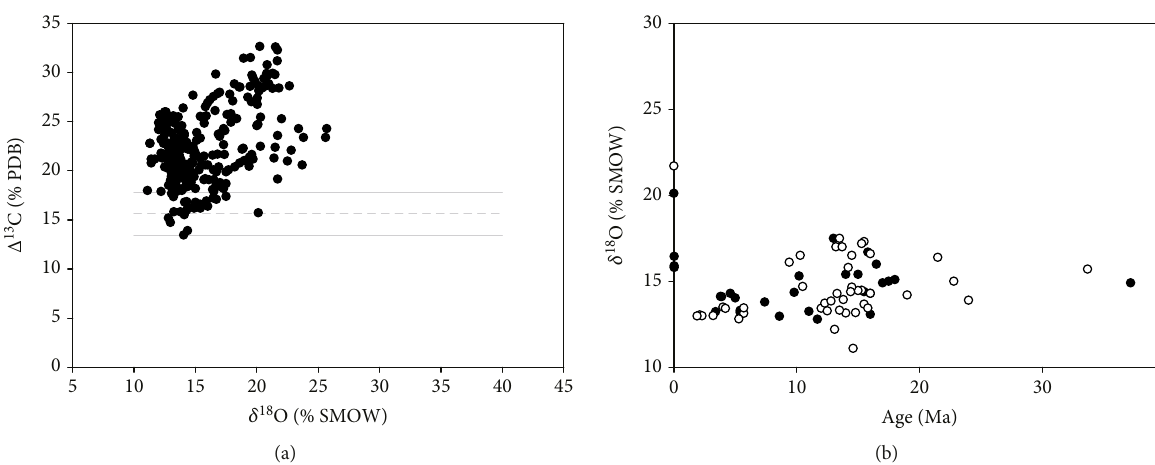
Figure 9: Montana paleoelevation revisited. (a) Plot of δ 18 O versus Δ 13 C for the past 75Ma in southwestern Montana (data from [22]). carb Based upon the theoretical and empirical constraints from Figures 3 and 5, the data set has been literally decimated, with only 29 of 308 (9.4%) pedogenic carbonates were formed in isotopic equilibrium and most of the data are extremely out of equilibrium (note the scale change versus Figure 8). (b) Plot of the remaining pedogenic carbonates that formed in isotopic equilibrium (black circles). Almost all of the structure in the dataset present in Figure 1 is gone. If one allows for evaporative due to water stress on the plants producing the organic matter of +1.5 ‰ (see text for discussion), the white circles would also represent equilibrium conditions. However, in both cases, little or no change in elevation is indicated by δ 18 O values, and there are essentially no pre-Miocene data points that can be used to assess the previously identi fi ed elevation carb change between 50 and 30Ma ago identi fi ed by Chamberlain et al.